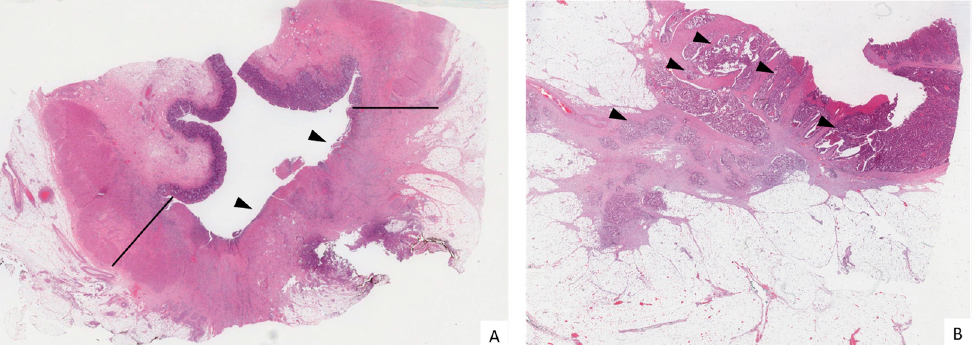
Figure 1. Histological sections of two surgical samples of LARC after nCRT. ( A ) TRG0 sample. In the area of the neoplasm, included between the black lines, there is extensive fibrosis of the rectal wall without residual cancer. The mucosa is ulcerated (arrow heads). ( B ) TRG3 sample. The rectal wall is still massively infiltrated by neoplastic glands (arrow heads). (Hematoxylin/Eosin, 5×). Table 1. Clinical–pathological characteristics of the 26 patients included in the study.